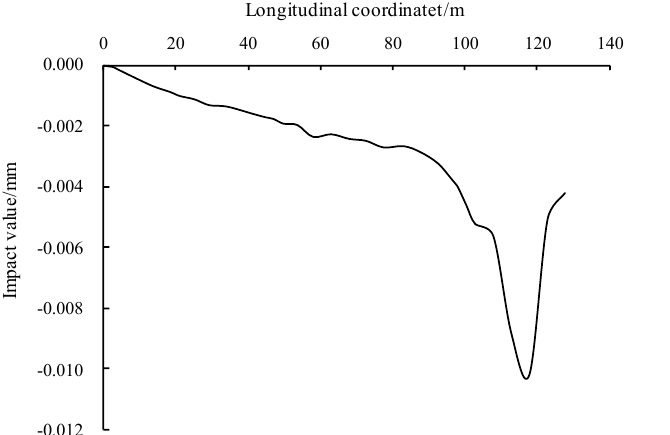
Figure 11. Longitudinal distribution of additional deflection caused by shear deformation at segmental joints.